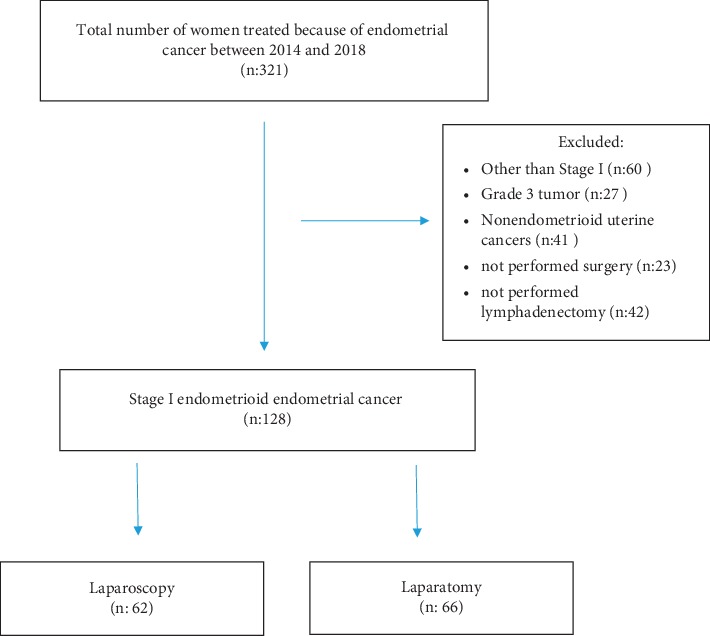
Study population.